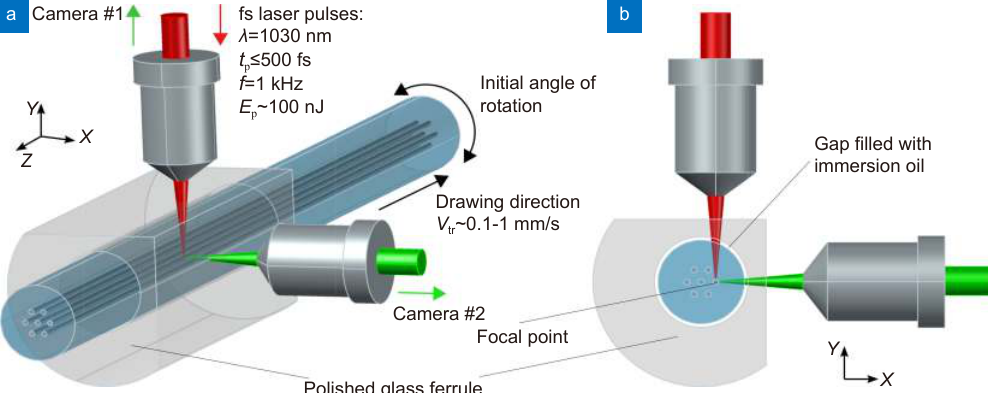
Fig. 5 | Focusing the fs laser beam into a selected core of the MCF during FBG writing. ( a ) 3D view. ( b ) 2D view in XY plane.